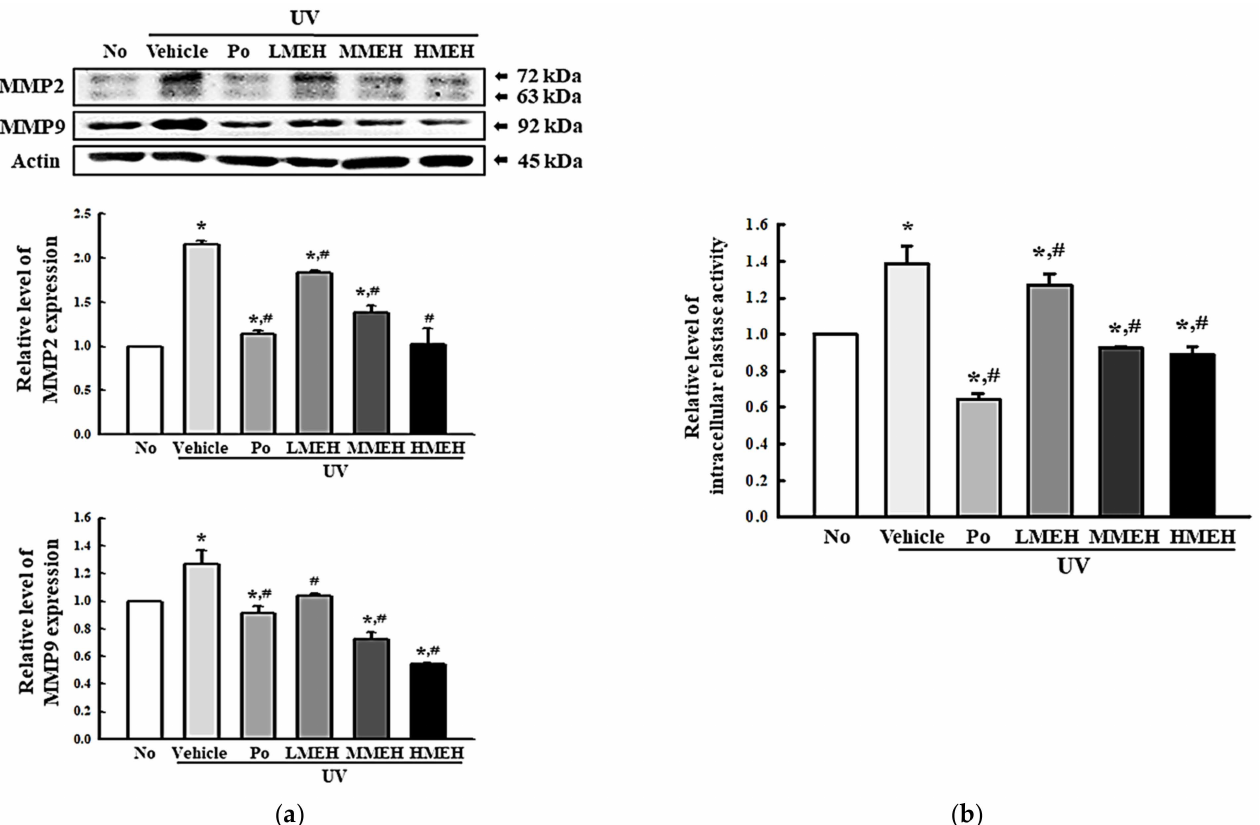
Figure 7. Detection of MMPs and elastase in normal human dermal fibroblasts. ( a ) Levels of MMP-2 and MMP-9. Three dishes per group were used to prepare the cell lysates. Western blot analysis was performed in triplicate and repeated for three times. The relative level of elastase activity ( b ) was determined in total cell lysate using the substrate. Three dishes per group were used to prepare the cell lysates, and the elastase activity assay was performed in triplicate. This experiment was performed for three times and results are the average of all experiments. The data are reported as the means ± SD. * p < 0.05 compared to the untreated group. # p < 0.05 compared to the UV + Vehicle group. Abbreviations: MMP, Matrix metalloproteinase; Po, Positive control; MEH, Methanol extract of Hygrophila erecta (Brum. F.)